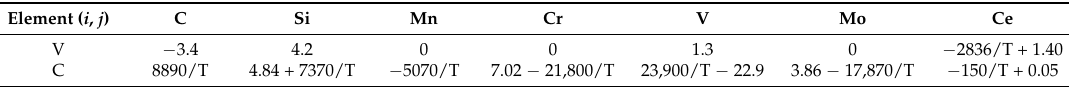
of various elements in liquid steel at 1873 i